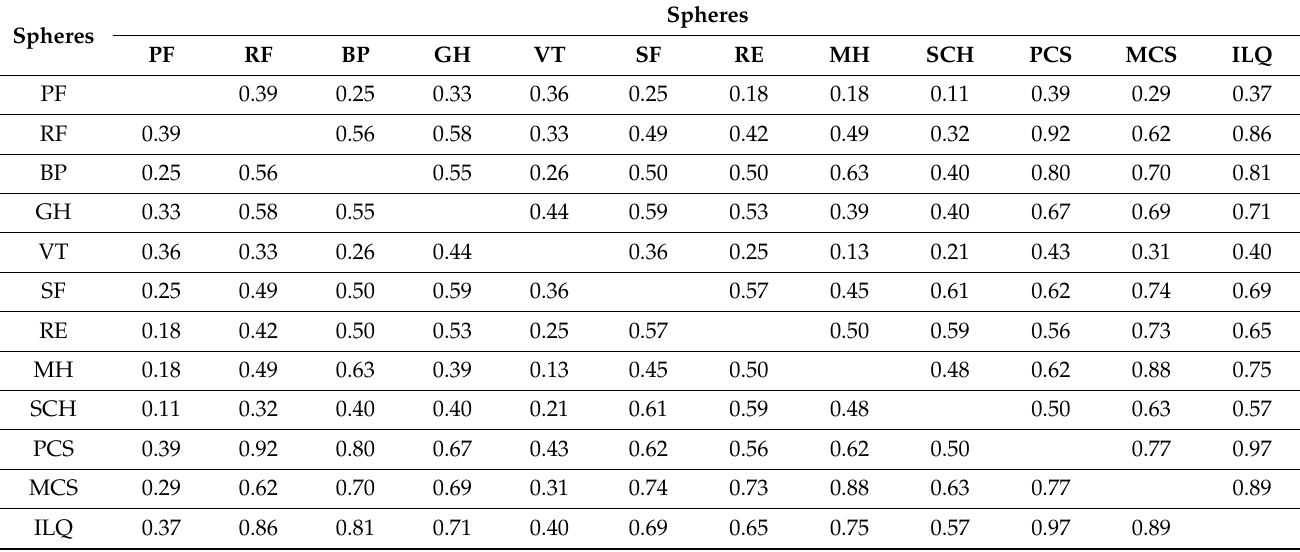
Table A1. Correlations of SF-36 spheres for all groups (Spearman’s r